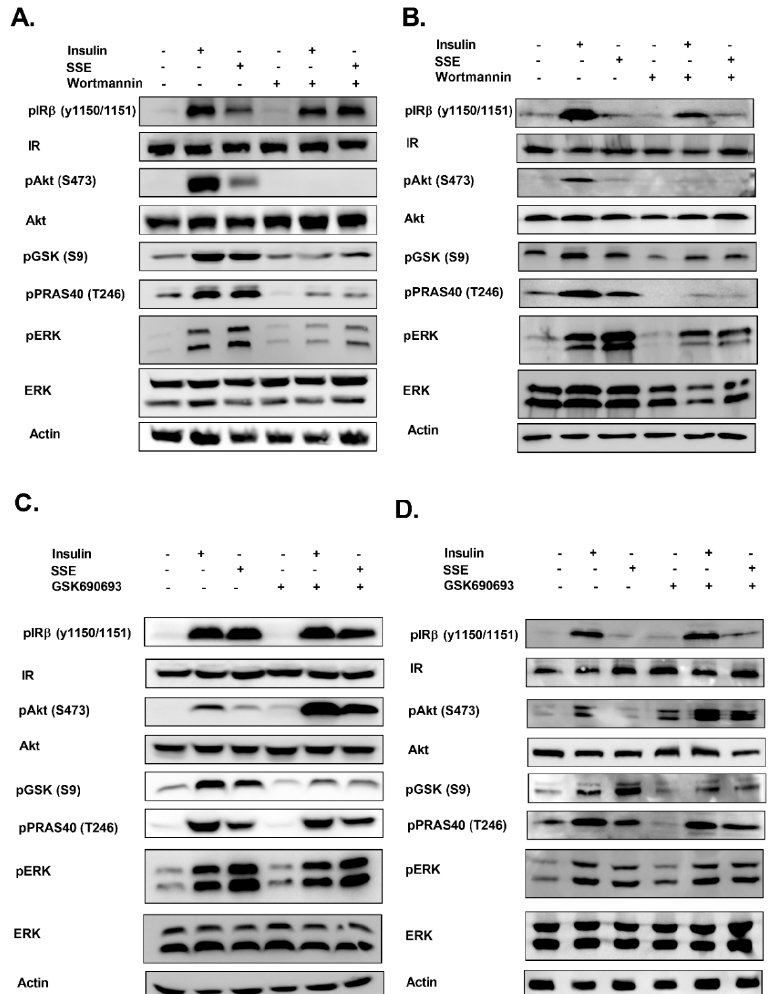
Figure 6. Role of PI3K and Akt in SSE-dependent phosphorylation of signaling proteins. L6 myotubes and 3T3-L1 adipocytes were treated with wortmannin (100 nM) ( A , B , respectively) or GSK690693 (1 µ M) ( C , D , respectively), as indicated, for 30 min followed by additional 10 or 30 min treatment (in L6 and 3T3-L1, respectively) with insulin or SSE. Western blot analysis was performed as described